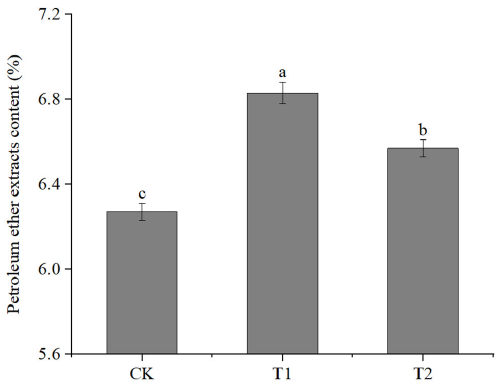
Figure 3. Comparison of petroleum ether extracts of flue-cured tobacco after cured (%).